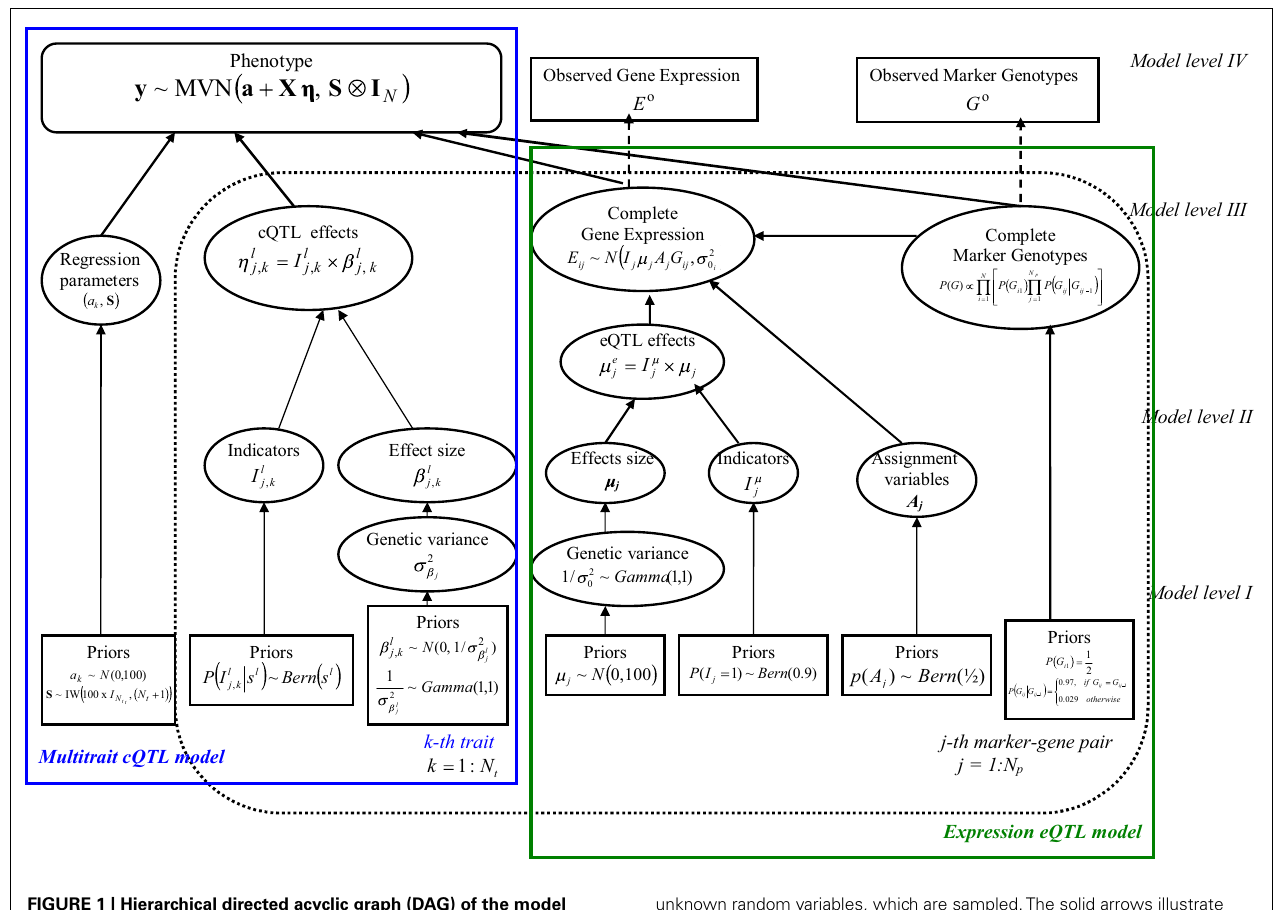
FIGURE 1 | Hierarchical directed acyclic graph (DAG) of the model structure. The pre-specified values (Model level I) or observed data (Model level IV) are given in boxes. Ellipses (Model levels II and III) refer to the